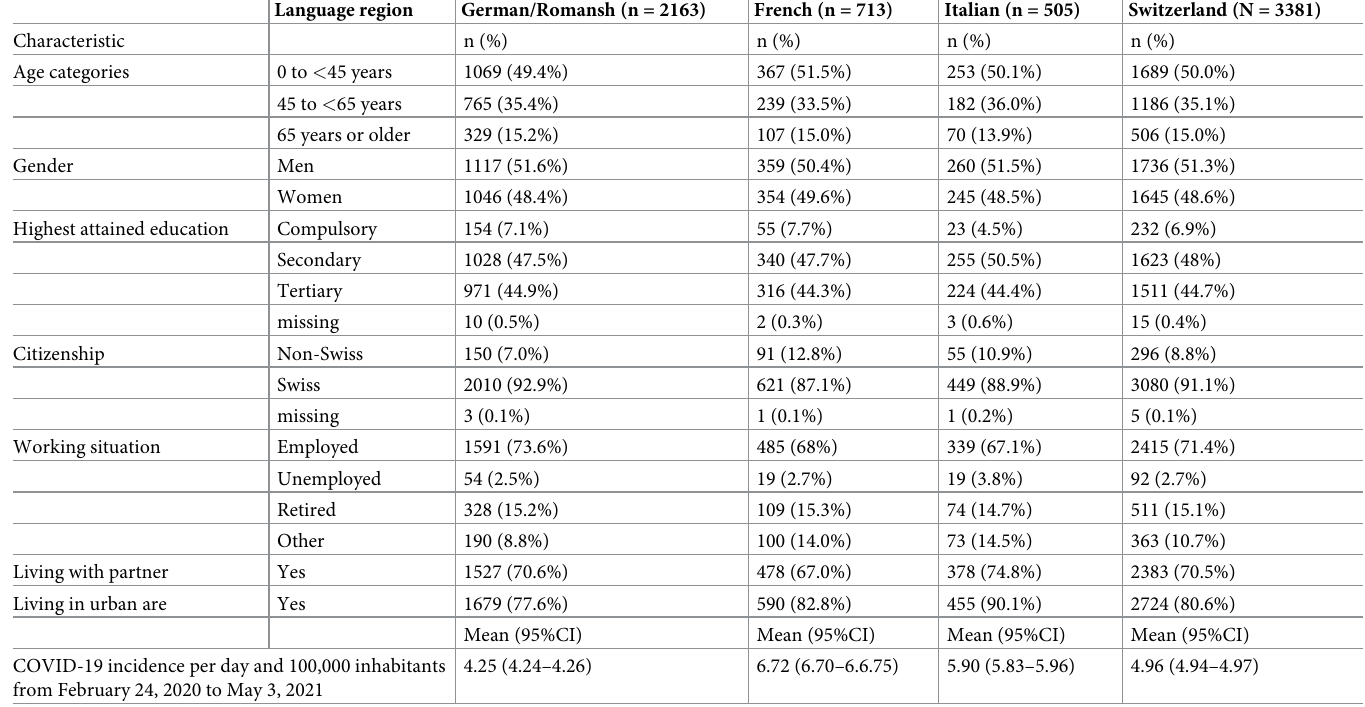
Table 3. Survey population baseline characteristics and COVID-19 incidence, by language